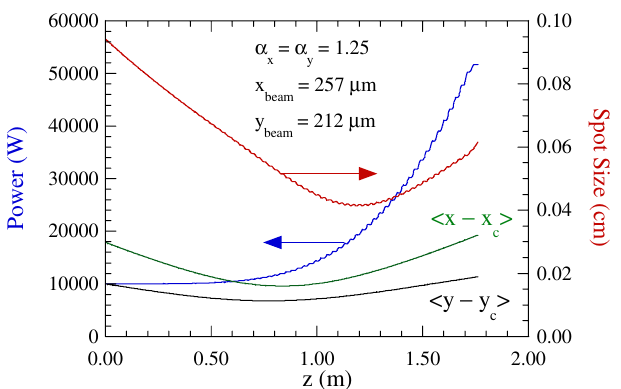
FIG. 4. (Color) Plot of the power versus time through the pulse at the wiggler entrance and exit. This corresponds to the small- signal regime.